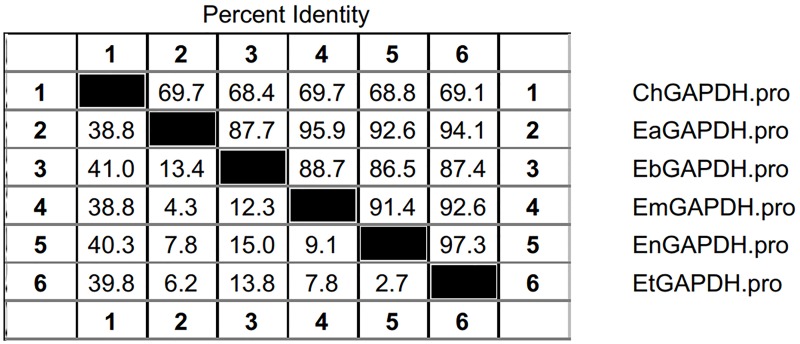
Amino acid similarities of GAPDH between Eimeria acervulina, E. maxima, E. tenella, E. necatrix, and E. brunetti. ChGAPDH = GAPDH of Chicken; EtGAPDH = GAPDH of E. tenella; EaGAPDH = GAPDH of E. acervulina; EmGAPDH = GAPDH of E. maxima; EnGAPDH = GAPDH of E. necatrix; EbGAPDH = GAPDH of E. brunetti.